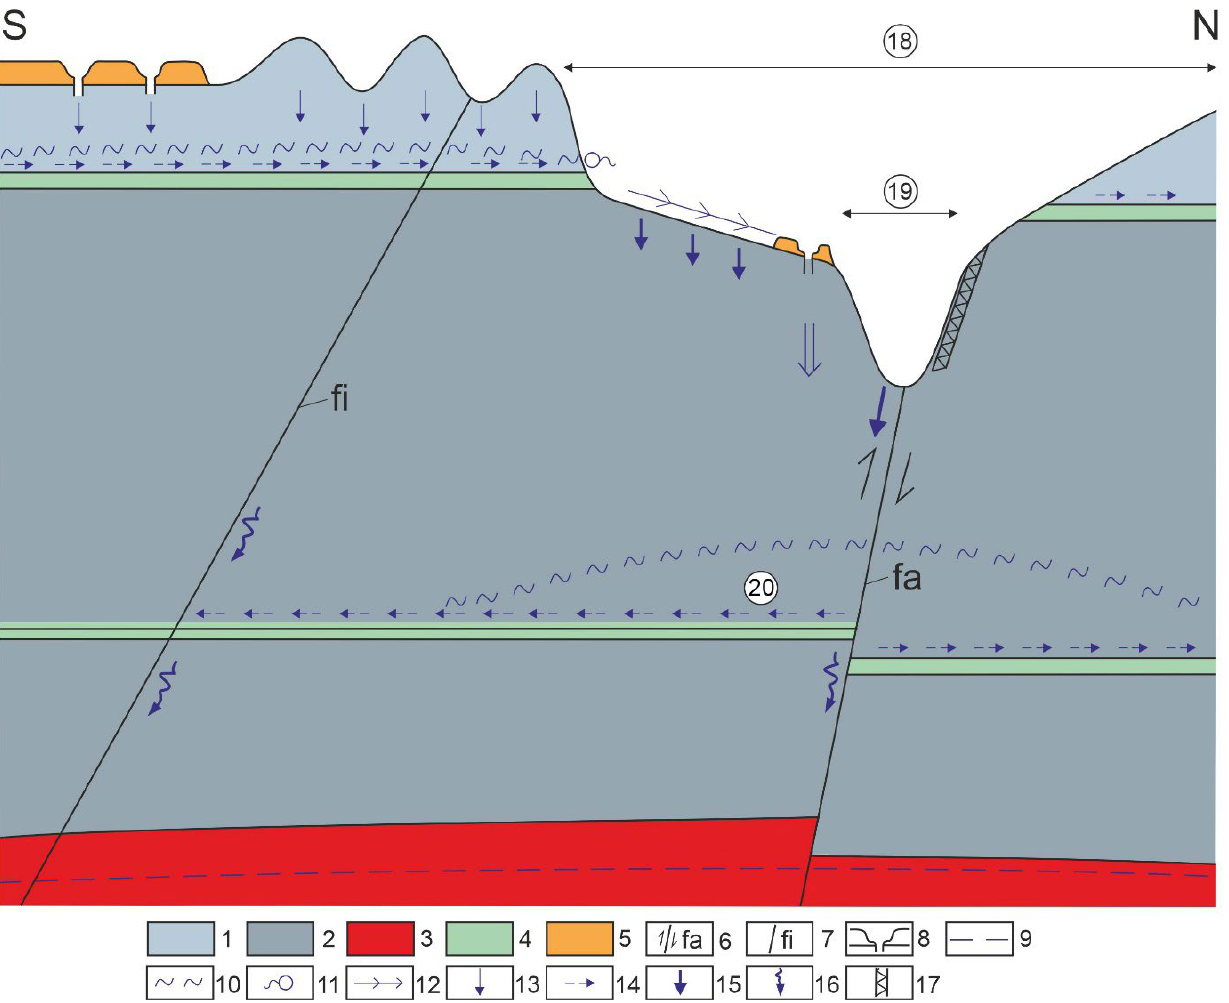
Figure 14. Complex, mixed epigene karst system in cross-section. Legend: 1. Limestone of Albian storey (Requinian limestone), 2. Limestone of Aptian storey, 3. Main dolomite, 4. Aquifuge, 5. Permeable cover, 6. Fault, 7. Fracture, 8. Subsidence doline, 9. Regional groundwater level, 10. Level of perched water table, 11. Spring, 12. Stream, 13. Diffuse infiltration, 14. Water motion above aquifuge, 15. Seepage in the channel, 16. Seepage along fault, fracture, 17. Pit remnants, 18. Epigenetic valley (Gerence valley), 19. Gorge, 20. Perched water table.